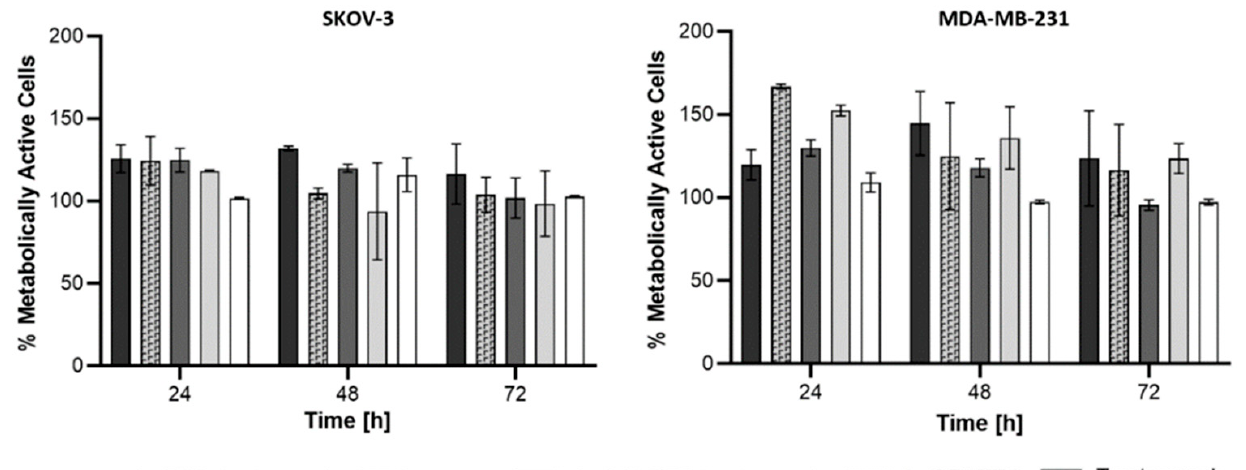
Figure 14. Metabolic activity of SKOV-3 and MDA-MB-231 cell after exposure for AuNP and Au@Pt conjugates.